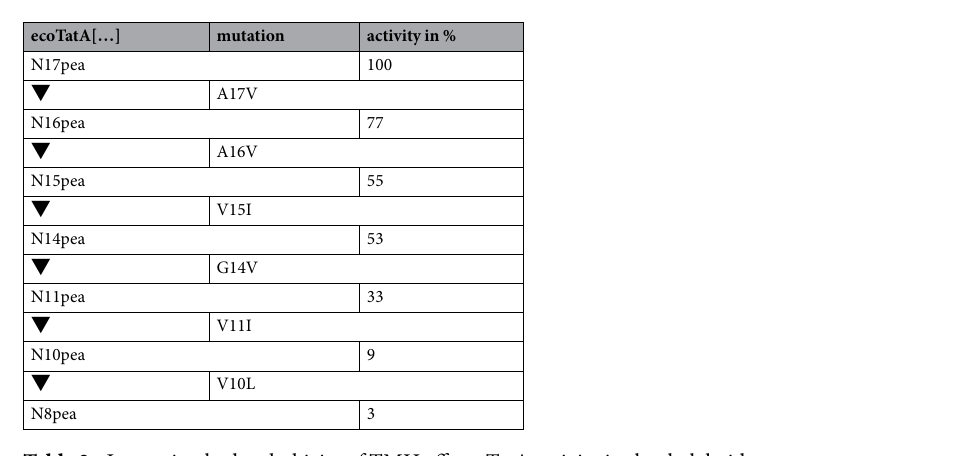
Table 2. Increasing hydrophobicity of TMH affects TatA activity in the thylakoid